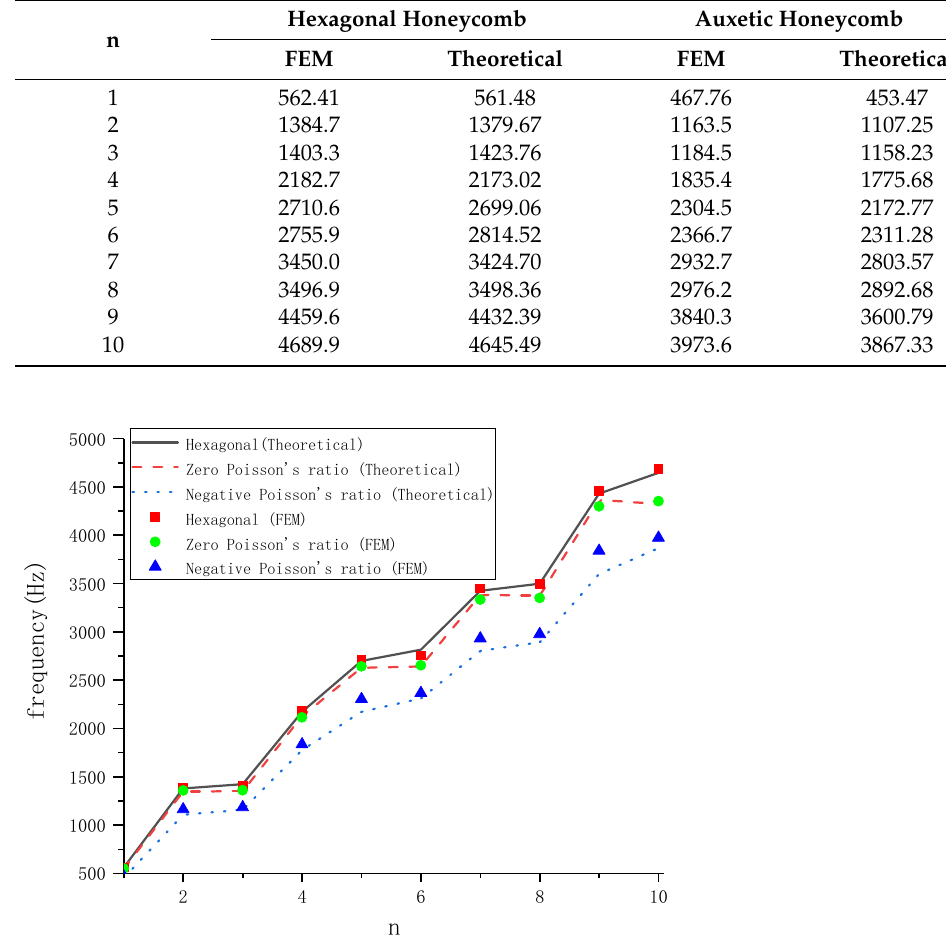
Table 2. The frequencies of the plate with regular hexagonal and concave hexagonal cores.